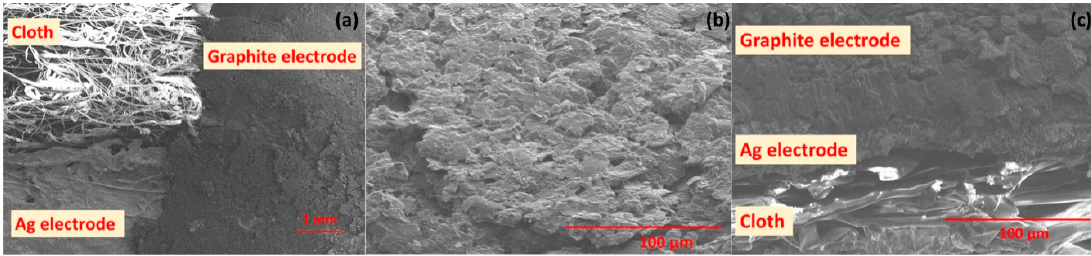
Figure 2. Scannng electron microscope (SEM) images: ( a ) top view of the sensitive electrode (SE) on cloth. ( b ) Surface morphology of the graphite sensitive electrode and ( c ) cross-sectional view of the layers of cloth, Ag electrode and graphite electrode.